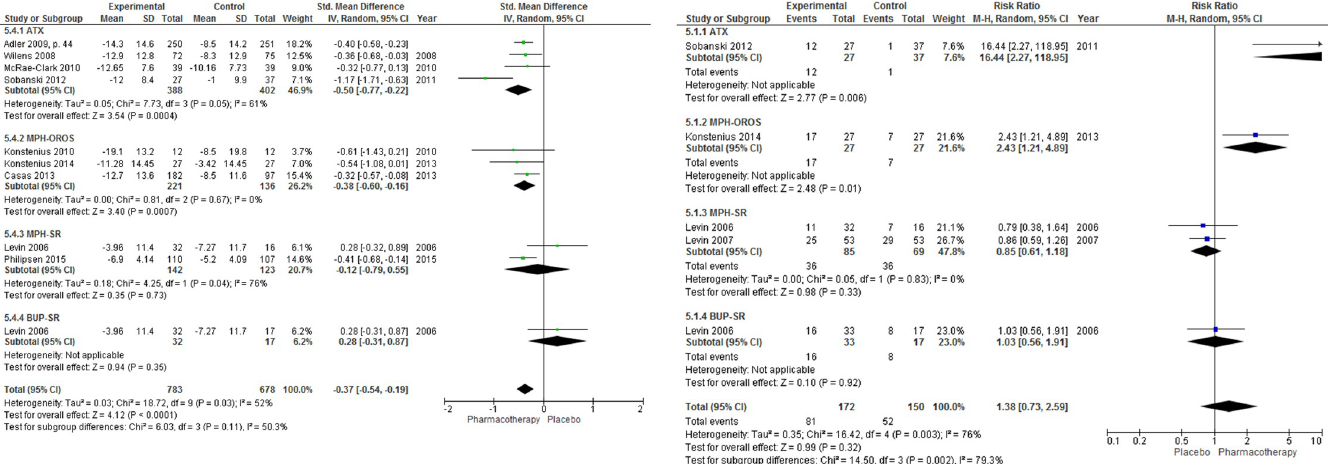
Fig 3. Patient-reported clinical response. Clinical response among patients who received any ADHD pharmacotherapy (versus placebo) in trials with a treatment duration of at least 12 weeks. (A) Continuous measure of response. (B) Dichotomous (treatment response: yes versus no).